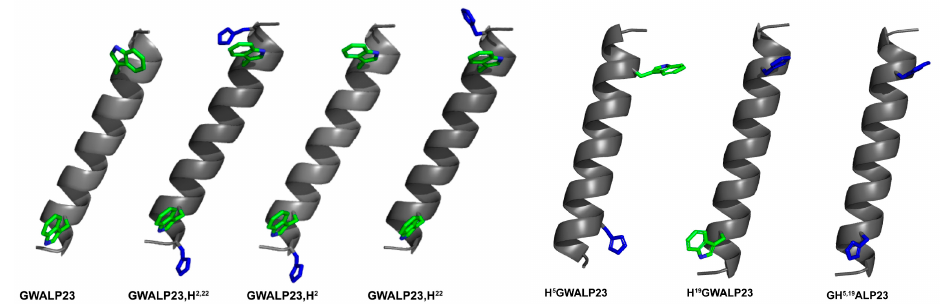
Figure 1. Pymol [29] representation of GWALP23 family peptides with histidine mutations in different locations. The His imidazole rings are blue, and the Trp indole rings are green with blue nitrogens. The depicted side-chain orientations and helix tilt are arbitrary. The sequences are shown in Table 1. Table 1. Sequences of GWALP23 peptides with single and double histidine substitutions.